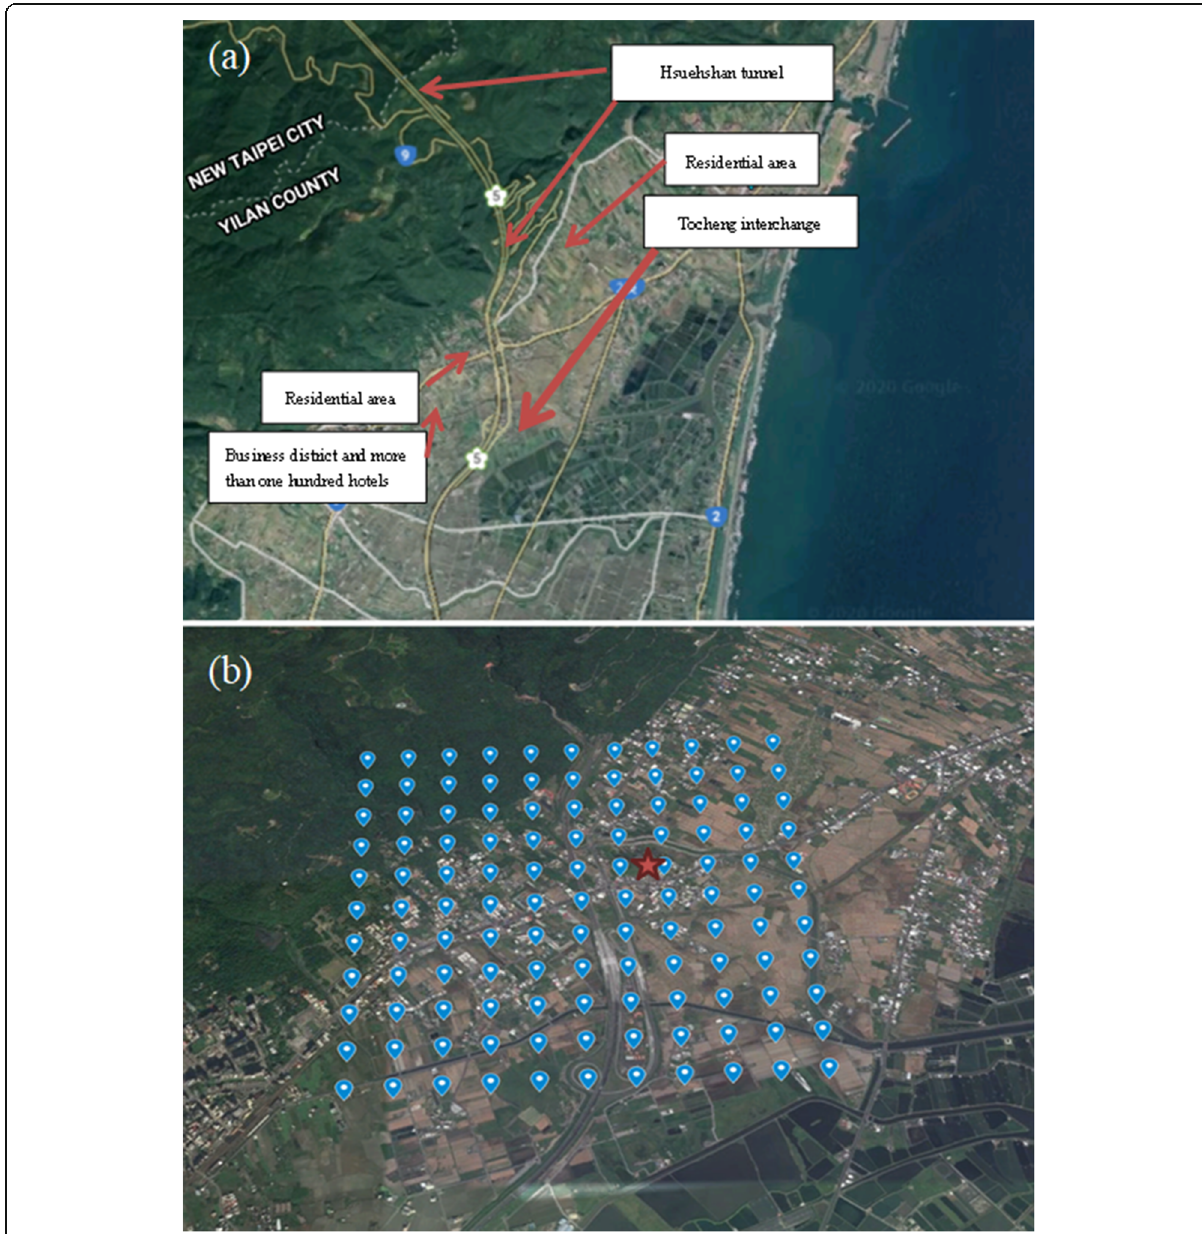
Fig. 1 a Study region b Simulation points of